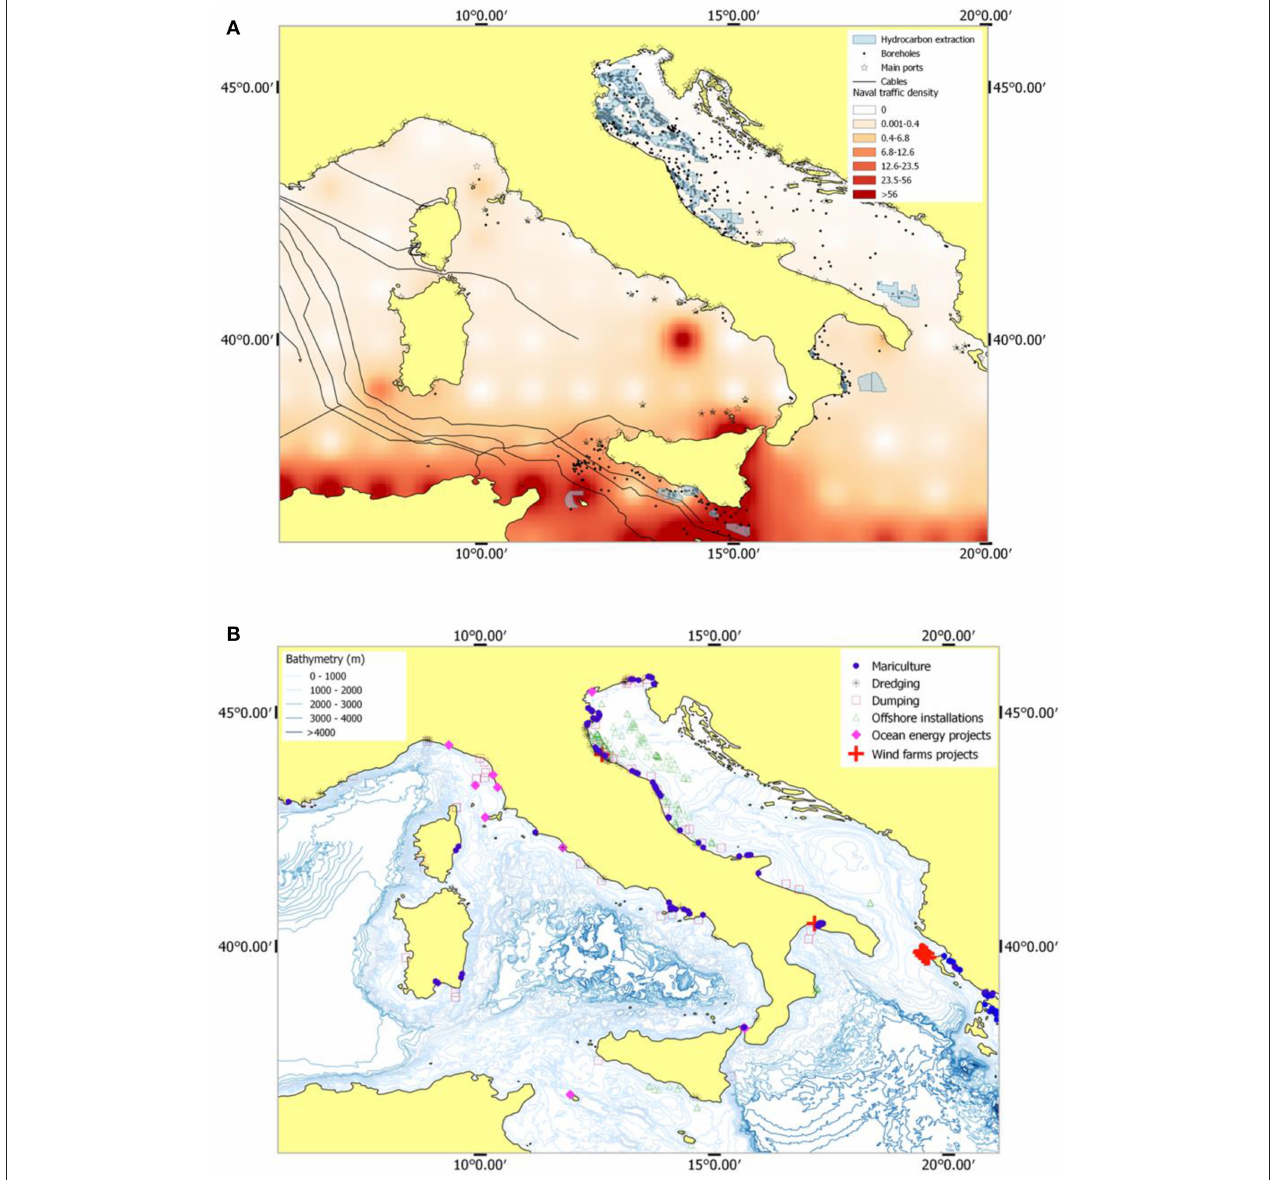
FIGURE 4 | Maps of the pressures: (A) hydrocarbon extraction and naval traffic; (B) mariculture, dredging and dumping and other activities.